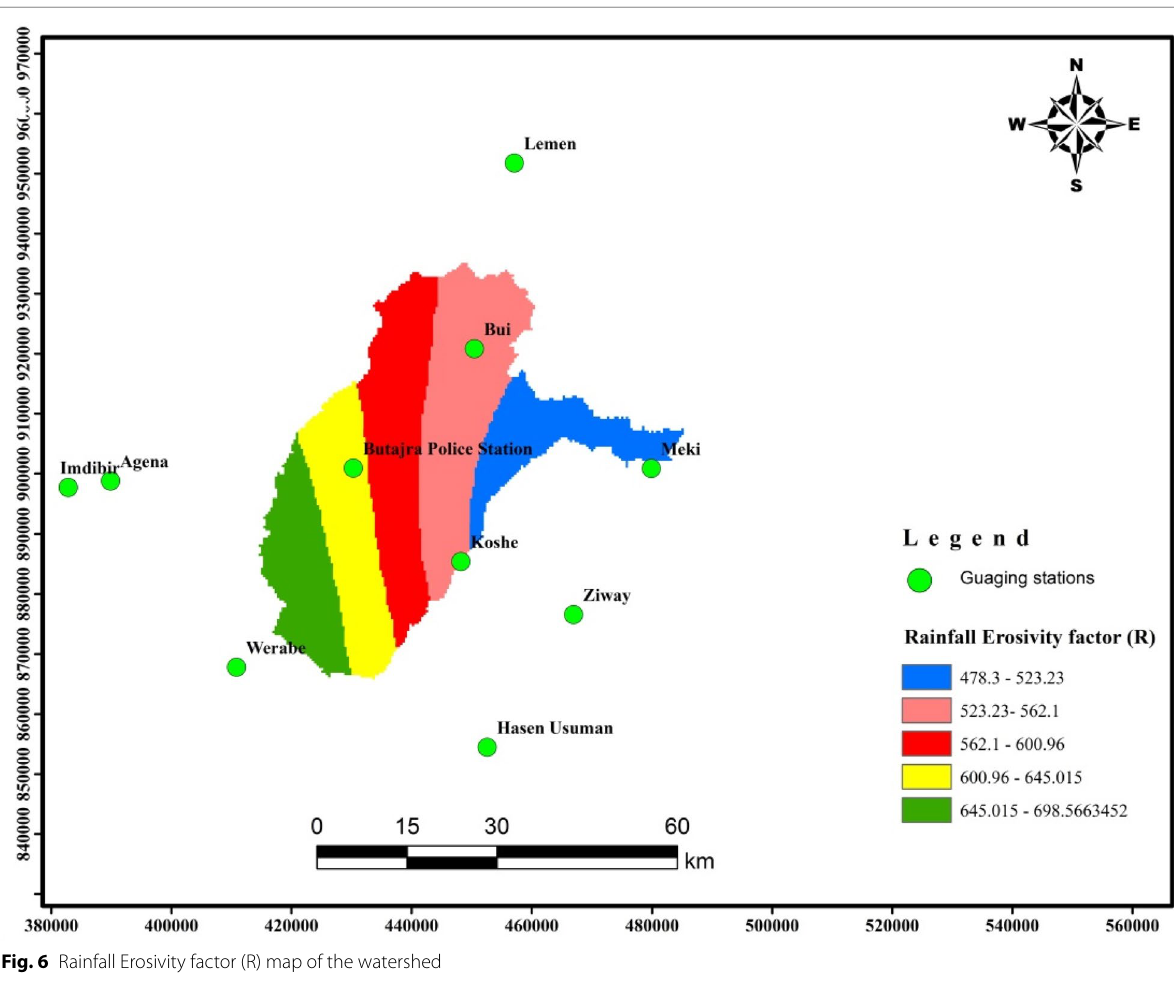
Fig. 6 Rainfall Erosivity factor (R) map of the watershed